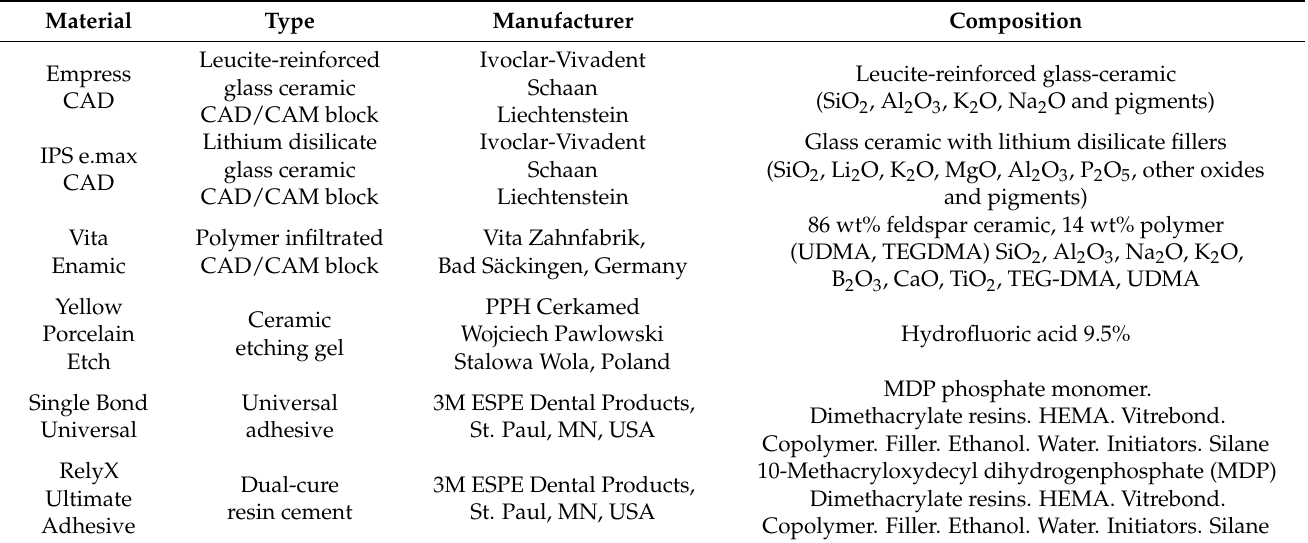
Table 1. Materials used in the study.